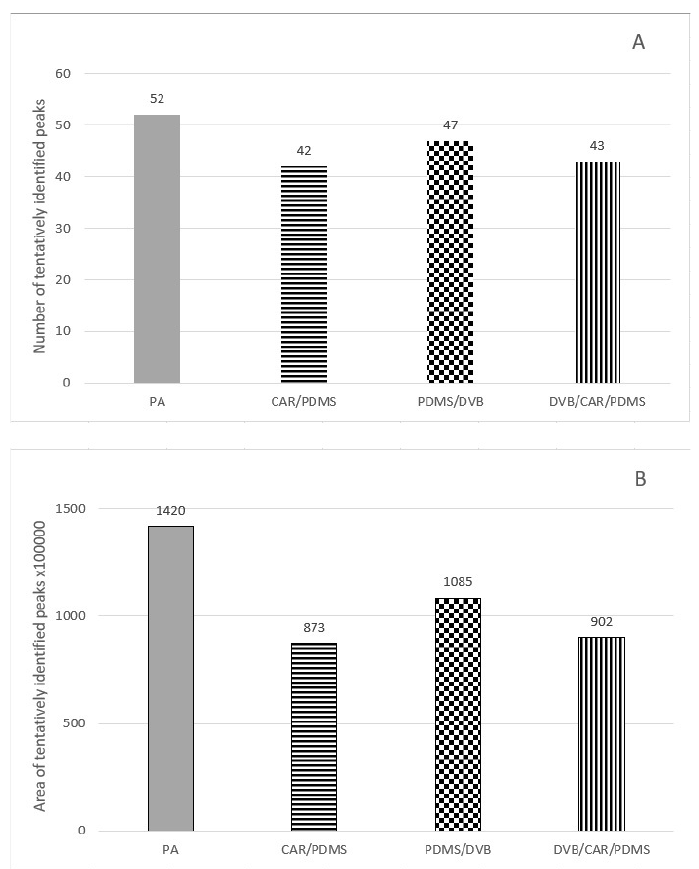
Figure 1. Comparison of the extraction efficiency of volatile compounds from Rondo wine by HS- SPME using different fibers under standard extraction conditions. Wine volume—3 mL in a 7 mL vial (undiluted wine); addition of NaCl—0.9 g; addition of diluted HCl—50 μ L; addition of internal standard—100 μ L; stirring speed—minimum; temperature of sample incubation—40 °C; time of sample incubation—15 min; temperature of extraction—40 °C; time of extraction—30 min. The results are expressed as ( A ) number of tentatively identified peaks and ( B ) area of tentatively identified